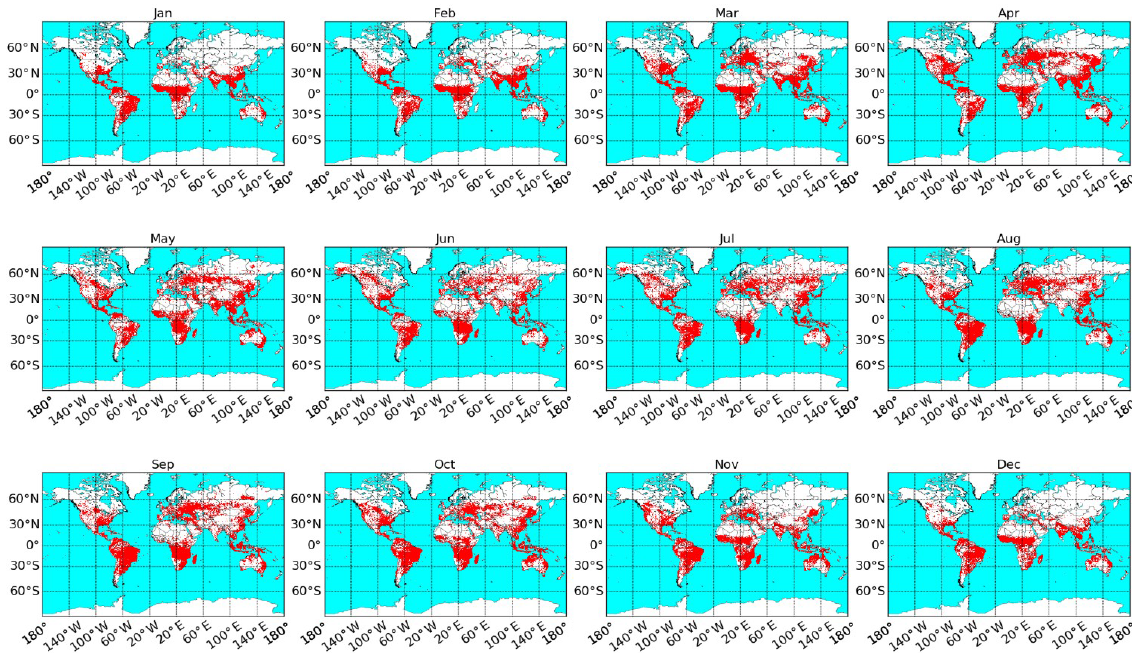
Figure 13. Global fire map from January to December 2015 accumulated from the FIRMS fire atlas.